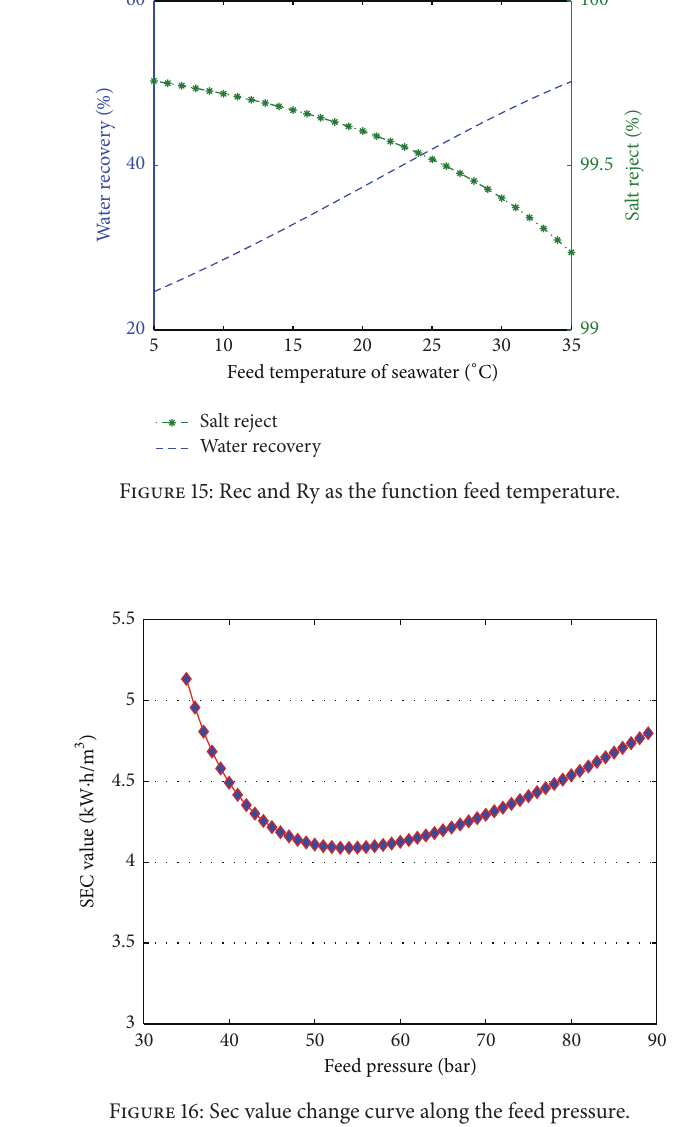
Figure 16: Sec value change curve along the feed